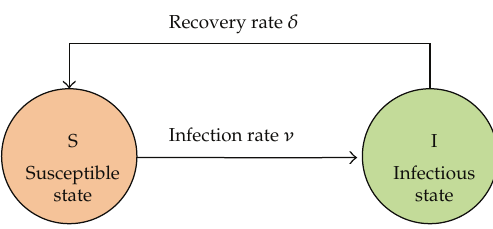
Figure 1: Susceptible-Infectious-Susceptible (cid:3) SIS (cid:4) state transfer